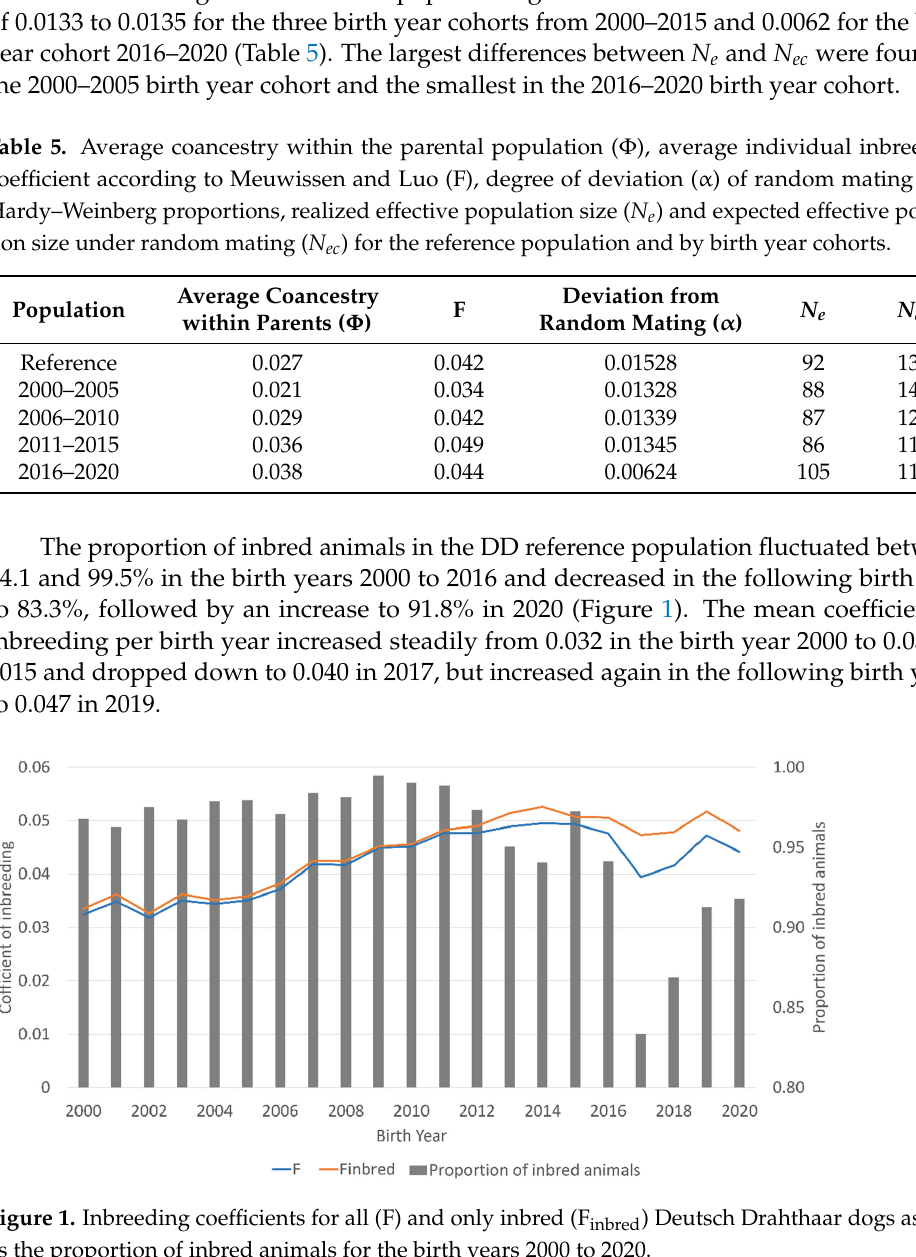
Figure 1. Inbreeding coefficients for all (F) and only inbred (F inbred ) Deutsch Drahthaar dogs as well as the proportion of inbred animals for the birth years 2000 to 2020.